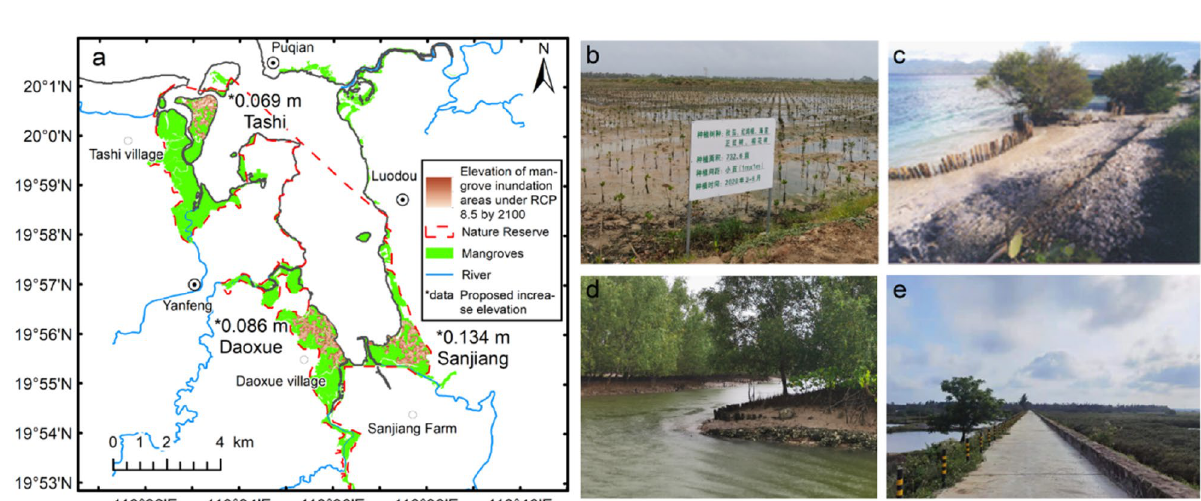
Figure 8. Measures for addressing SLR in coastal wetlands. ( a ) Heights of biological berms not less than 0.069, 0.086, and 0.134 m for the mangrove wetlands at the seaward side of Tashi village, Yanfeng, and Sanjian farm in Dongzhaigang, respectively; the shaded areas are projected to be inundated under RCP 8.5 by the end of 2100; ( b ) Restoration of mangrove from aquaculture and mudflat; ( c , d ) Biological embankment measures for sediment material acquisition in coastal wetlands (credit to: Poh Poh Wong); ( d ) Aquaculture ponds and cofferdams that block the mangrove naturally landward migrated. Maps generated in ArcMap v10.0 (https:// www. esri. com/ en- us/